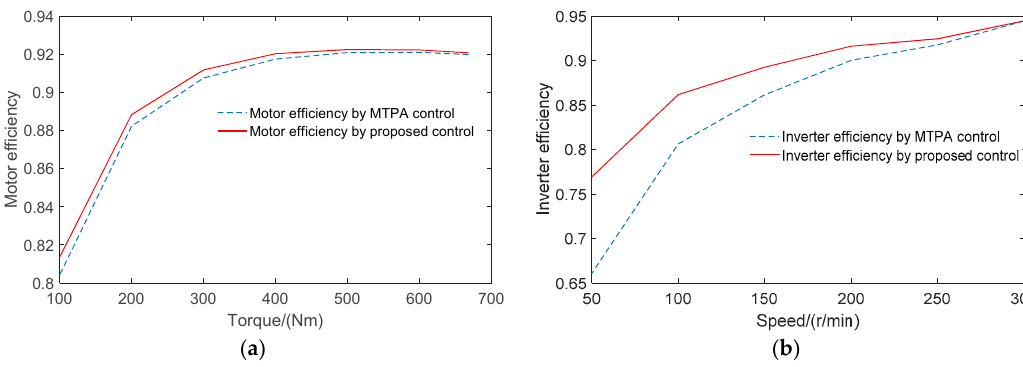
Figure 10. Efficiency optimization performance on the motor efficiency and inverter efficiency by the proposed system efficiency improvement control. ( a ) Motor efficiency at rated speed; ( b ) inverter efficiency at rated torque.